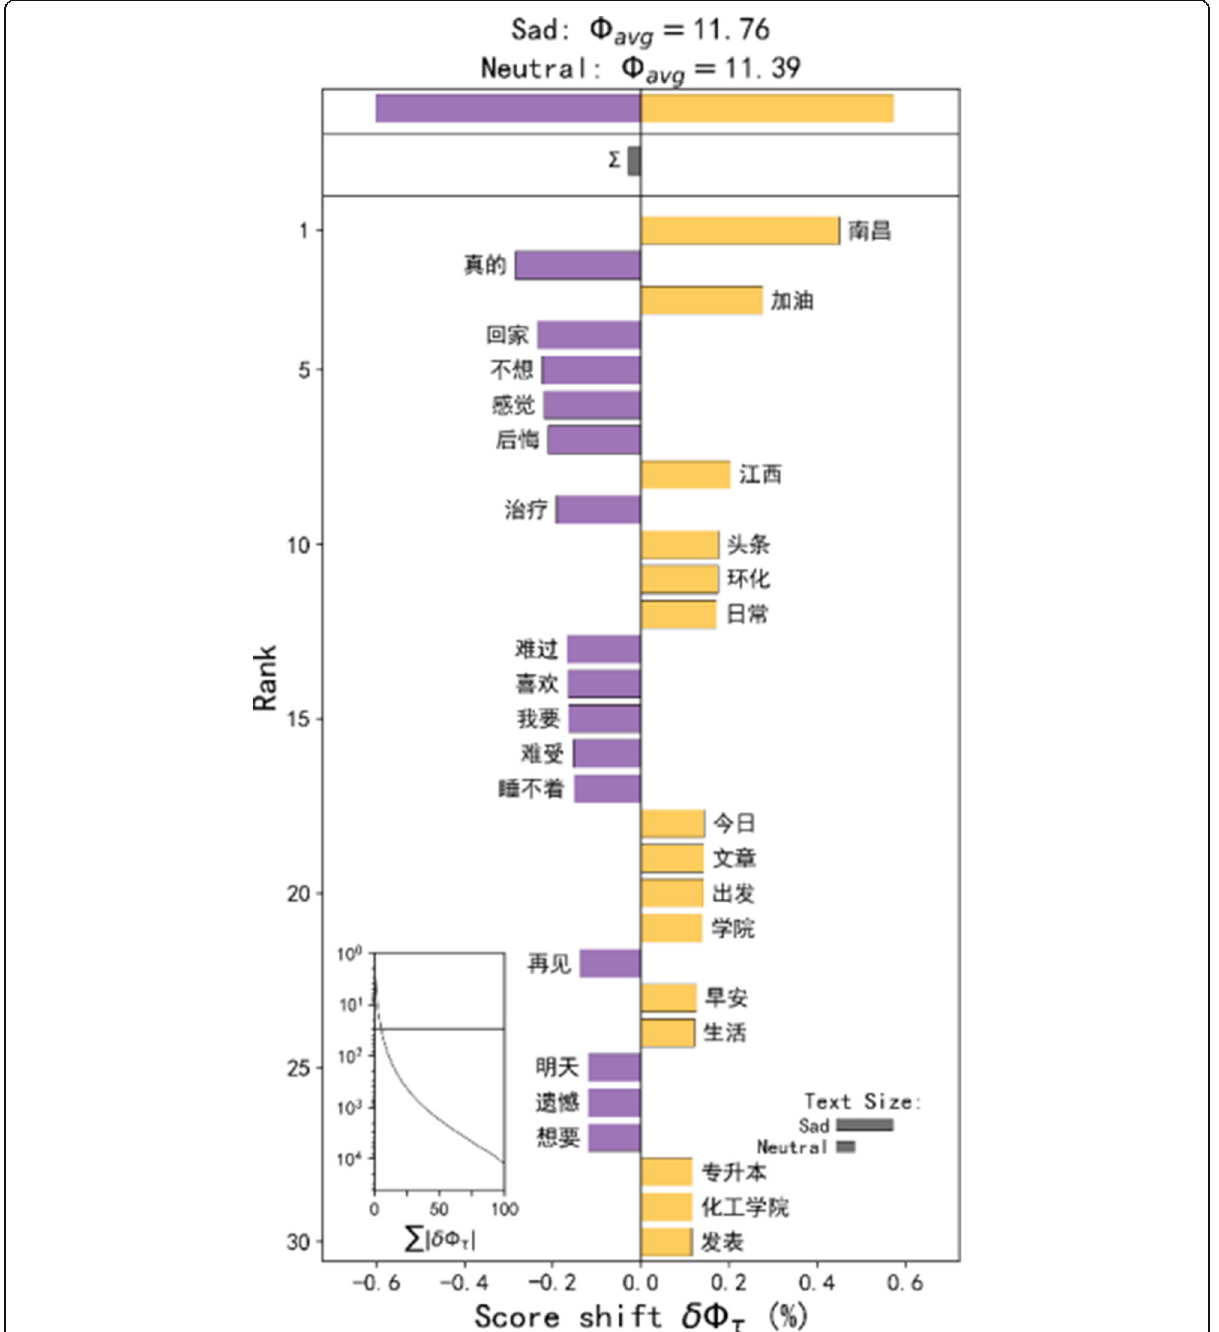
Fig. 6 Word shift graphs of the Weibos in the sad emotion hot